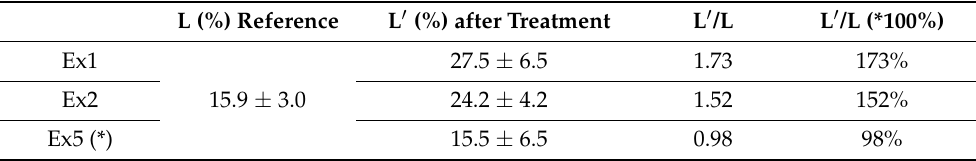
Table 2. Mean elongation before (L) and after (L (cid:48) ) treatment. L (%) Reference L (cid:48) (%) after